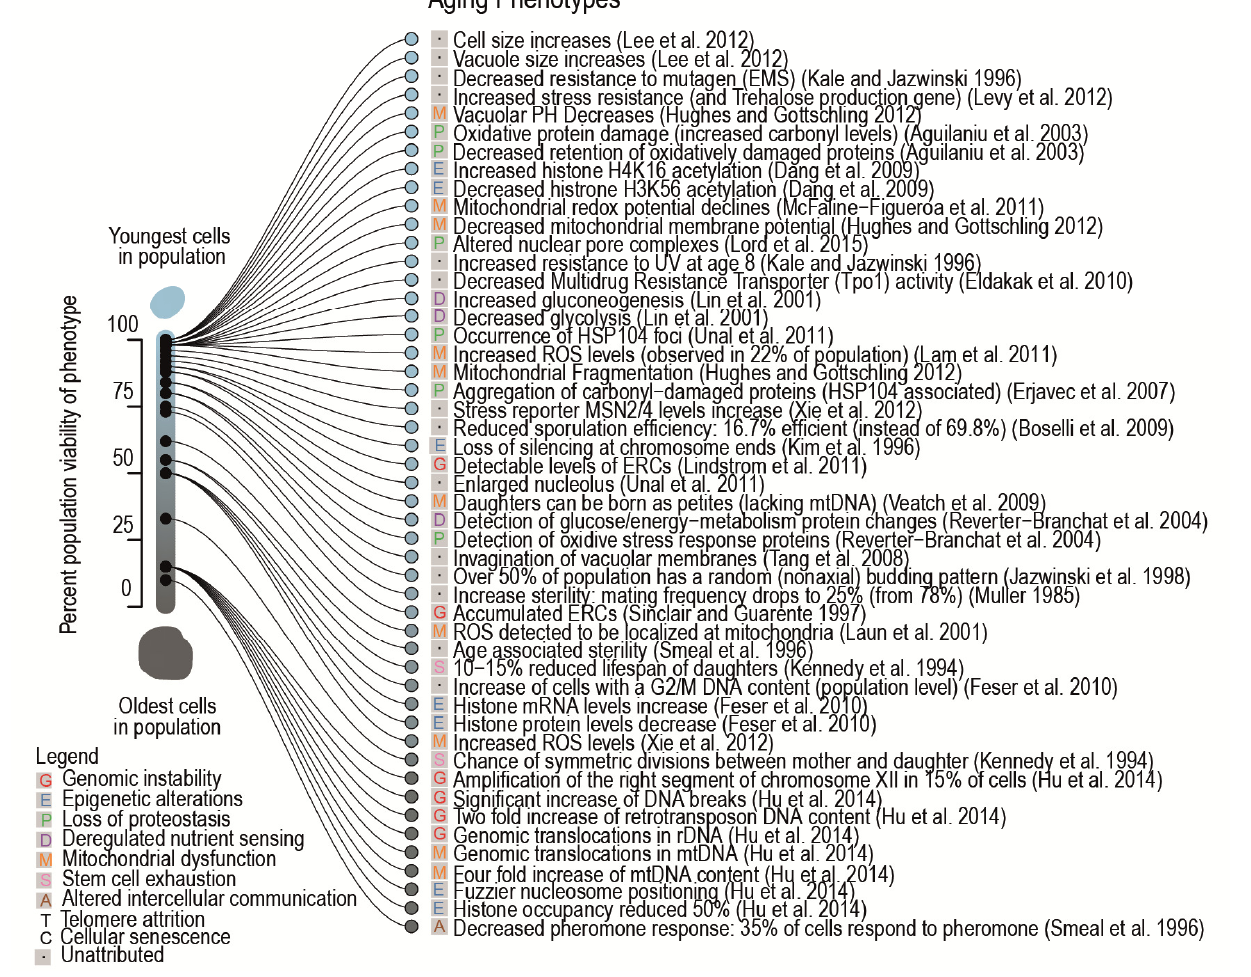
FIGURE 1: Phenotypes occurring in the yeast replicative lifespan. Observations collected from primary literature as discussed herein and as associated to a relevant hallmark of aging (symbol in legend). Cited references are often not the first to observe the phenotype but are se- lected based on the earliest most precise report of the timing within the RLS (i.e. while [23, 24] described aged cells to be larger than young, [25] clearly observed this increase in size for a specific age, namely from the beginning on, when 100% of the population was still viable). Percentage of viability, at which age-related phenotype occurs in the population, was either directly taken from the primary literature source, or inferred based on the age of the yeast used in the publication, its average lifespan (if provided), or the average lifespan estimated from a compiled lifespan